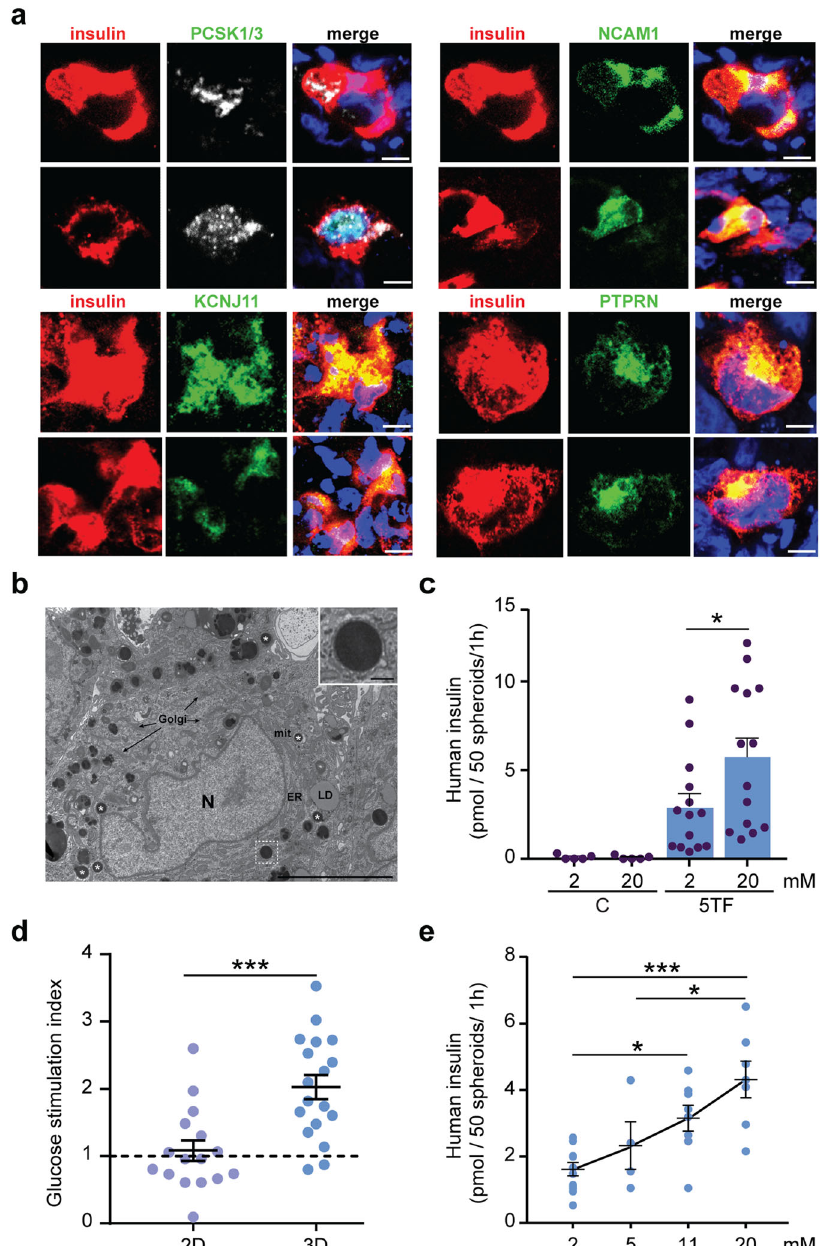
Fig. 6 Insulin secretion by 5TF cell spheroids. a Representative confocal images of 5TF cell spheroids immunostained with the indicated antibodies. Scale bar, 10 μ m. b Conventional transmission electron microscopy showing a representative image of a 5TF cell spheroid. Prototypical electron dense secretory vesicles (asterisks) are observed dispersed in the cytoplasm. Well-preserved mitochondria (mit), endoplasmic reticulum (ER), Golgi membranes (G) and lipid droplets (LD) are also observed. Inset shows a detail of a secretory vesicle with an average diameter of 450 nm. N, nucleus. Scale bars are 200 nm (inset) and 500 nm. c In vitro glucose-induced insulin secretion by 5TF cell spheroids ( n = 14, from 8 reprogramming experiments). Secretion by control spheroids composed of parental fi broblasts ( n = 5) is also shown. d Glucose stimulation Index (ratio between insulin secreted at 20 mM glucose vs. 2 mM glucose) of 5TF cells maintained in 2D or in 3D (spheroid) cultures ( n = 16 – 18, from 8 to 10